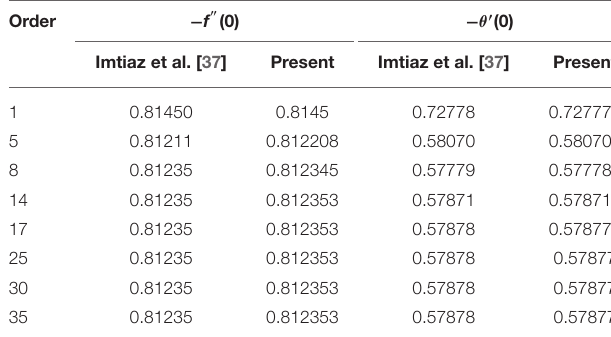
f ′′ (0) and θ ′ (0) for the limiting case − −